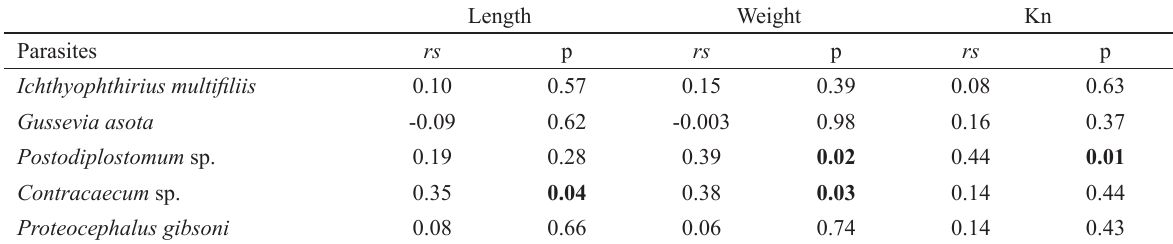
Spearman’s correlation coefficient ( rs ) for the abundance of parasites with the total length, body weight and relative condition factor (Kn) of Astronotus ocellatus from the Fortaleza Igarapé basin, in the eastern Amazon (Brazil).